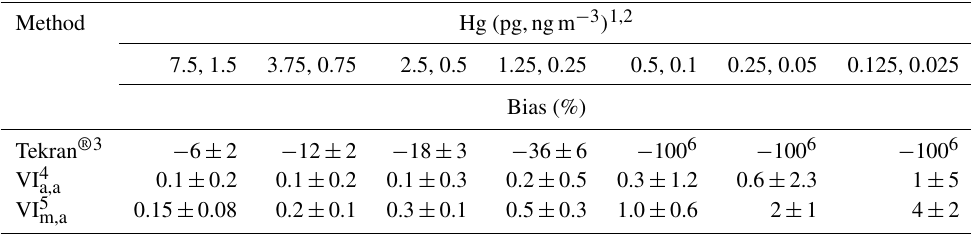
Figure 3. (a) Comparison of Hg loadings derived from measurements made with a Tekran ® 2537A instrument using the Tekran ® method and my VI-based Hg thermal desorption peak height determination method (dataset shown in Fig. 2, excluding SPANs), with the peaks defined manually (the VI m,m method). The equation of the linear regression is y = 1 . 00 ( 1 )x − 0 . 45 ( 8 ) pg ( r 2 = 0 . 997, n = 74). The fit excludes data derived from peaks not detected by the Tekran ® method (represented by the open symbols). (b) Absolute and relative biases in the Tekran ® -derived Hg loadings, based on the fit in panel (a) . The grey bands represent propagated uncertainties (95% confidence intervals) in the fit parameters. (c) Distribution of residuals from panel (a) , including only data derived from detected peaks. (Analogous results for the 2537B instrument are presented in Fig. S5.) Table 1. Bias in Hg loadings derived by applying automated and semiautomated Hg atomic fluorescence signal processing methods to measurements made with a Tekran ® 2537A